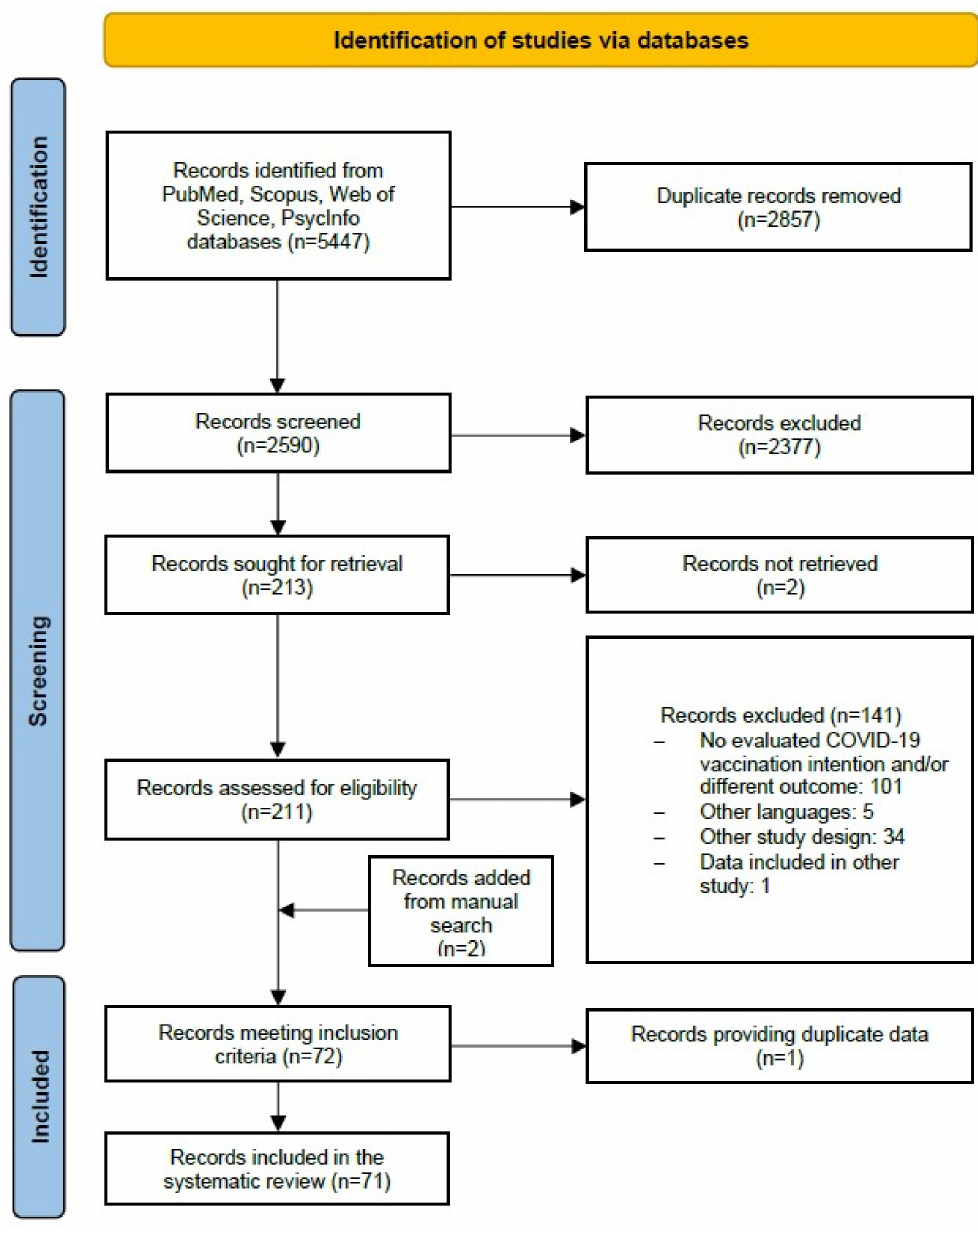
Figure 1. PRISMA flow diagram of the review